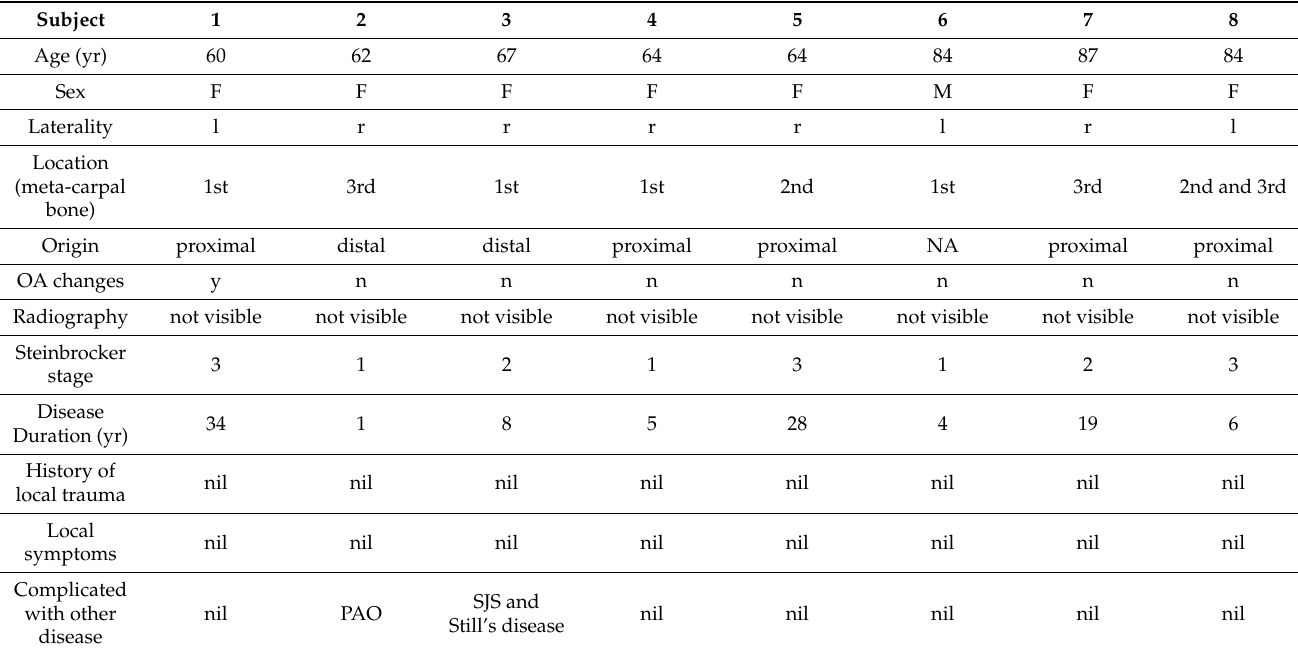
Table 1. Basic clinical characteristics of subjects.